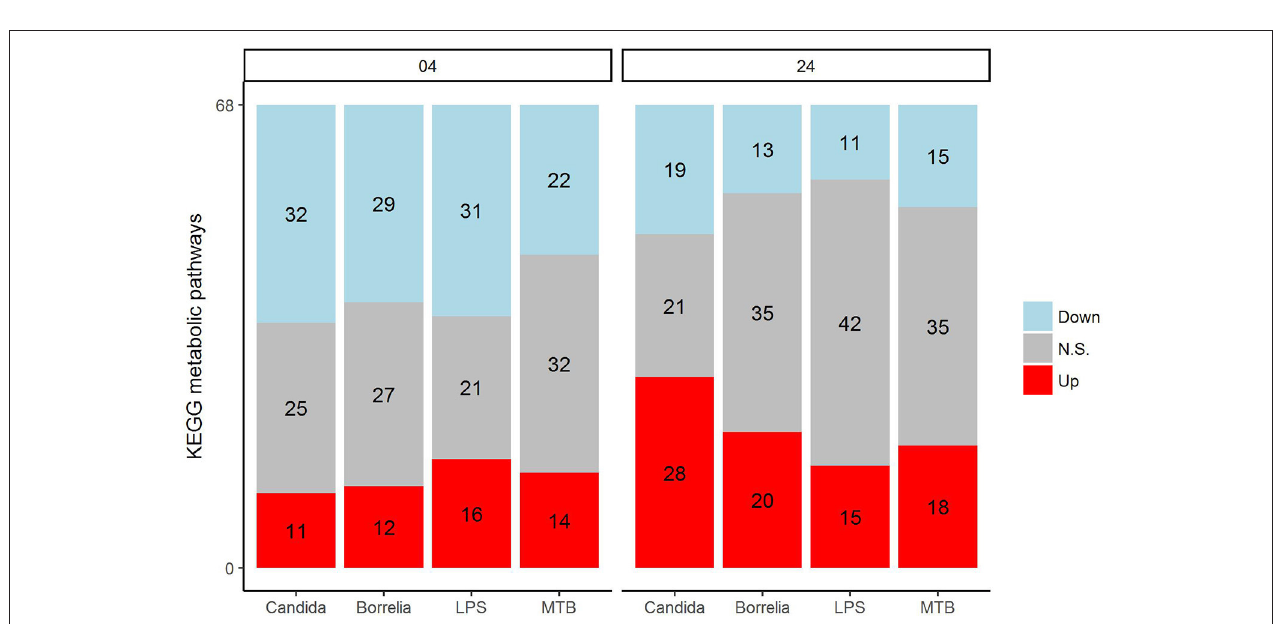
FIGURE 2 | Distribution of significantly up-regulated (red), down-regulated (blue), and not significantly changed (gray) pathways in 68 KEGG metabolic pathways for Candida , Borrelia , LPS, and MTB-stimulated human PBMCs at 4 and 24 h. Any metabolic pathway is significantly changed if its FDR < 0.05.